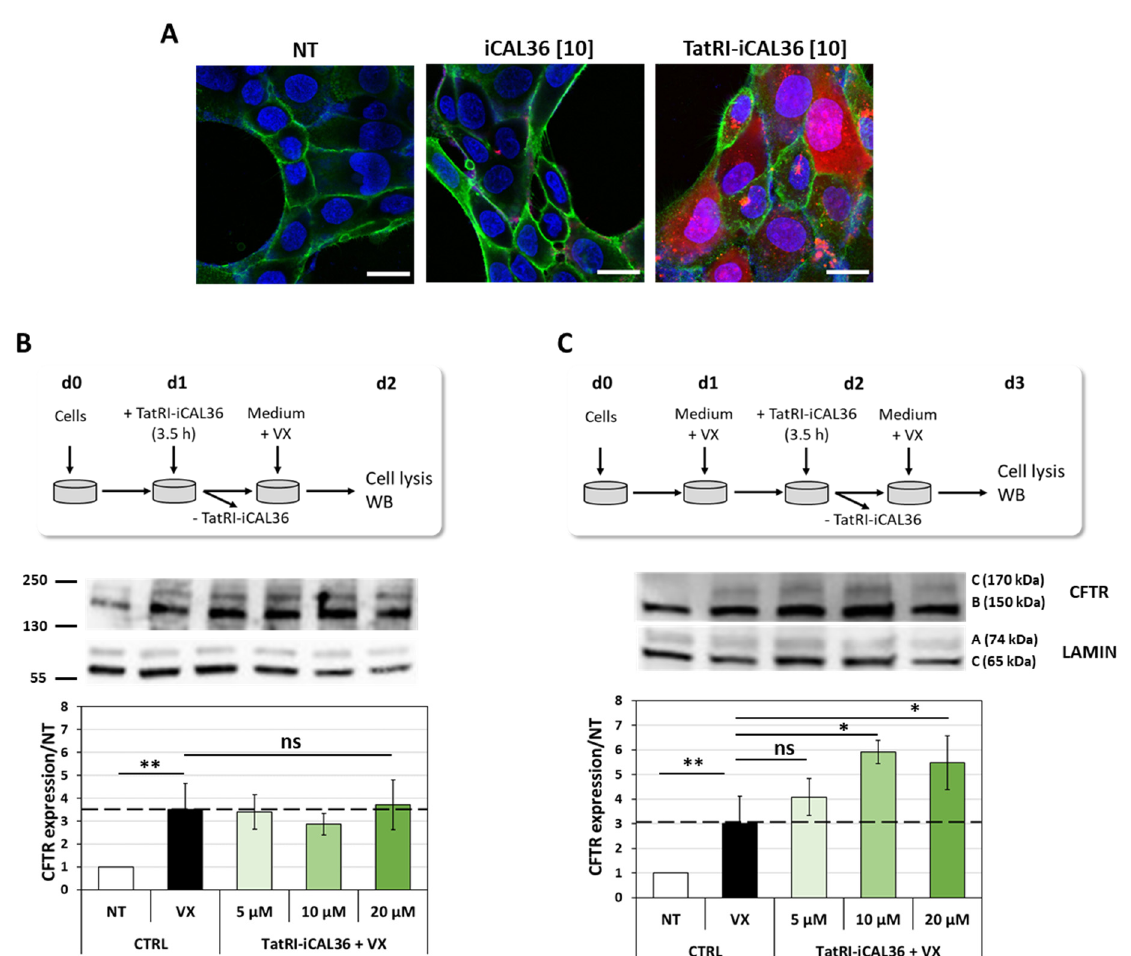
Figure 5. Dissecting the internalization and activity of TatRI-iCAL36 in 16HBEge cells. ( A ) Living 16HBEge cells were imaged by CLSM after 3 h incubation with Tamra-iCAL36 (10 μ M = [1]) or Tamra-TatRI-iCAL36 (10 μ M = [10])) in OptiMEM. Then, 10 min before the end of the incubation, Hoechst dye (blue) and WGA-Alexa488 (green) were added. Cells were washed and covered with DMEM FluoroBrite before imaging. White bars represent 10 μ m. ( B ) The 16HBEge cells were incubated with TatRI-iCAL36 (5 μ M, 10 μ M, or 20 μ M) in the presence of the corrector VX-445/VX-809 cocktail as indicated in the scheme. On day 2 (d2), the cells were lysed and p.Phe508del-CFTR was quantified by Western blot. Graphical representation of data obtained from three independent Western blot quantifications (mean ± SD, n = 3). A statistically significant difference was noted between non-treated (NT) and VX-445/VX-809-treated (VX) cells, whereas no statistical significance was revealed for the TatRI-iCAL incubation (one-way ANOVA with Bonferroni test, statistical relevance given as ** p < 0.01 and ns > 0.05). ( C ) The 16HBEge cells were pre-incubated with the corrected VX-445/VX-809 for 24 h. Afterward, the cells were incubated with TatRI-iCAL36 (5 μ M, 10 μ M, or 20 μ M) in the presence of the VX-445/VX-809 corrector cocktail as indicated in the scheme. On day 3 (d3), cells were lysed and p.Phe508del-CFTR was quantified by Western blot. Graphical representation of data obtained from three independent Western blot quantifications (mean ± SD, n = 3). A statistically significant difference was noticed between non-treated (NT) and VX-445/VX-809-treated (VX) cells, as well as between the VX-treated and the TatRI-iCAL36-treated cells at 10 μ M and 20 μ M (one-way ANOVA with Bonferroni test, statistical relevance given as ** p < 0.01, * p < 0.05 and ns > 0.05). First, we confirmed that the VX-445/VX-809 corrector cocktails increase the CFTR amount in the 16HBEge cells after 24 h incubation. Indeed, as shown in Figure 5B,